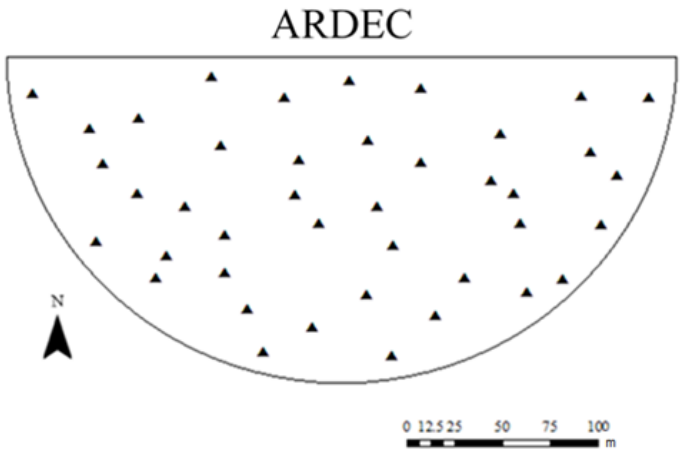
Figure 1. Map of the study field at Agricultural Research, Development and Education Center showing the location of neutron probe access tubes.